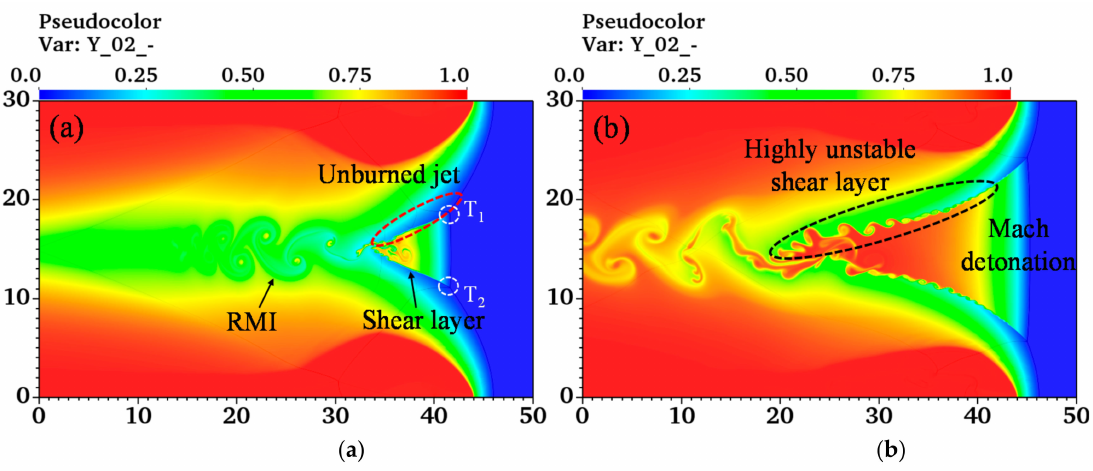
Figure 7. Contour of reaction progress variable after symmetric-jet initiation: ( a ) t = 162.5 µ s; ( b ) t = 180 µ